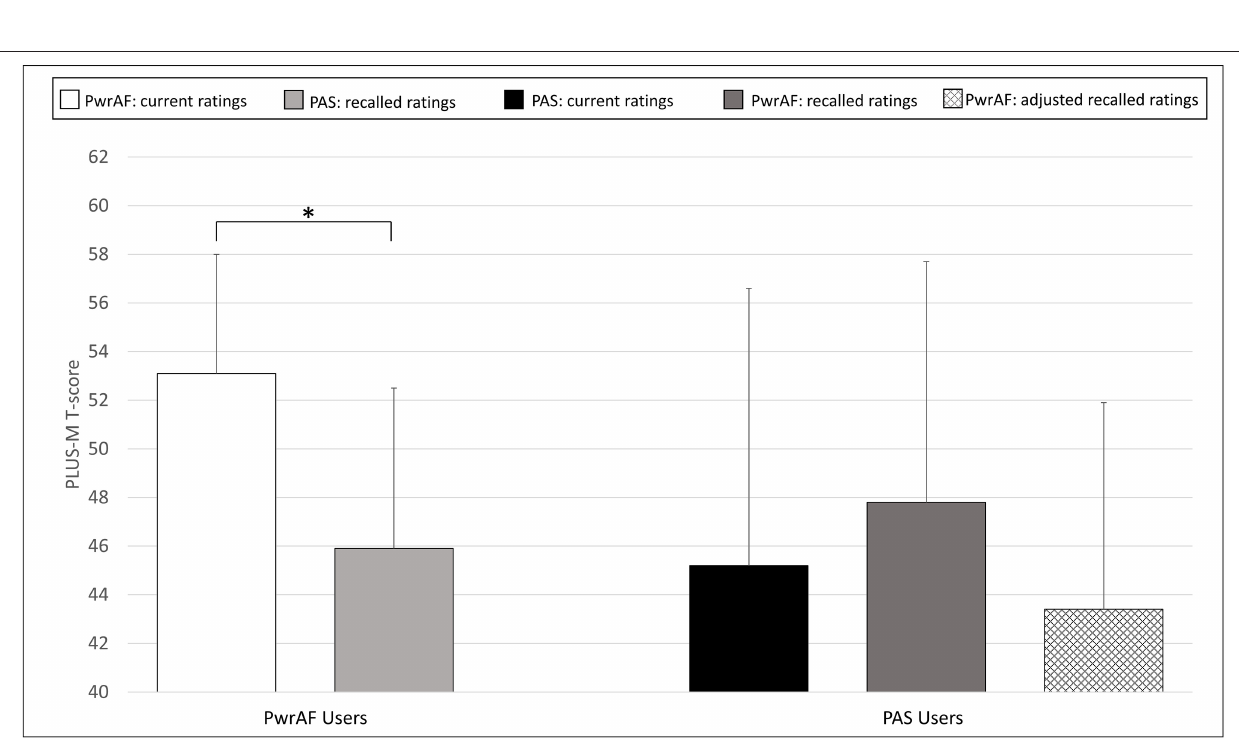
Frontiers in Rehabilitation Sciences |